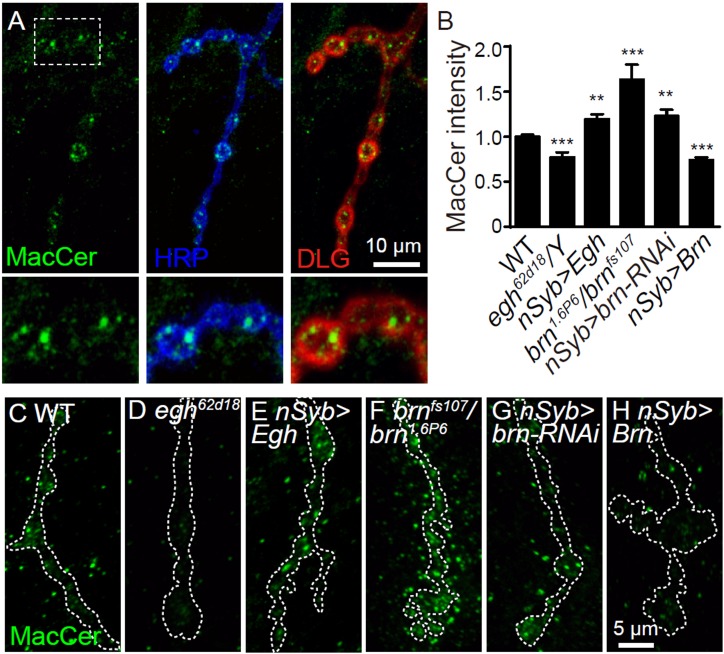
MacCer staining intensity at NMJs is bi-directionally regulated by Egh and Brn.(A) Images of wild-type NMJ4 co-stained with anti-MacCer (green), anti-HRP (blue) and anti-DLG (red).MacCer puncta were apparent in presynaptic boutons. Scale bar: 10 μm. (B) Statistical results of normalized intensities of MacCer against anti-HRP staining within presynaptic boutons in different genotypes. **p<0.01 and ***p<0.001 by student’s t test between a test genotype and wild type; n ≥ 16 larvae; error bars: s.e.m. (C–H) Representative images of NMJ4 stained with anti-MacCer in wild type (C), egh62d18/Y (D), UAS-Egh/+; nSyb-Gal4/+ (E), brn1.6P6/brnfs107 (F), UAS-brn-RNAi/+; nSyb-Gal4/+ (G) and nSyb-Gal4/UAS-Brn (H). Scale bar: 5 μm.10.7554/eLife.38183.009Figure 3—source data 1.Numerical data for the statistical graphs.